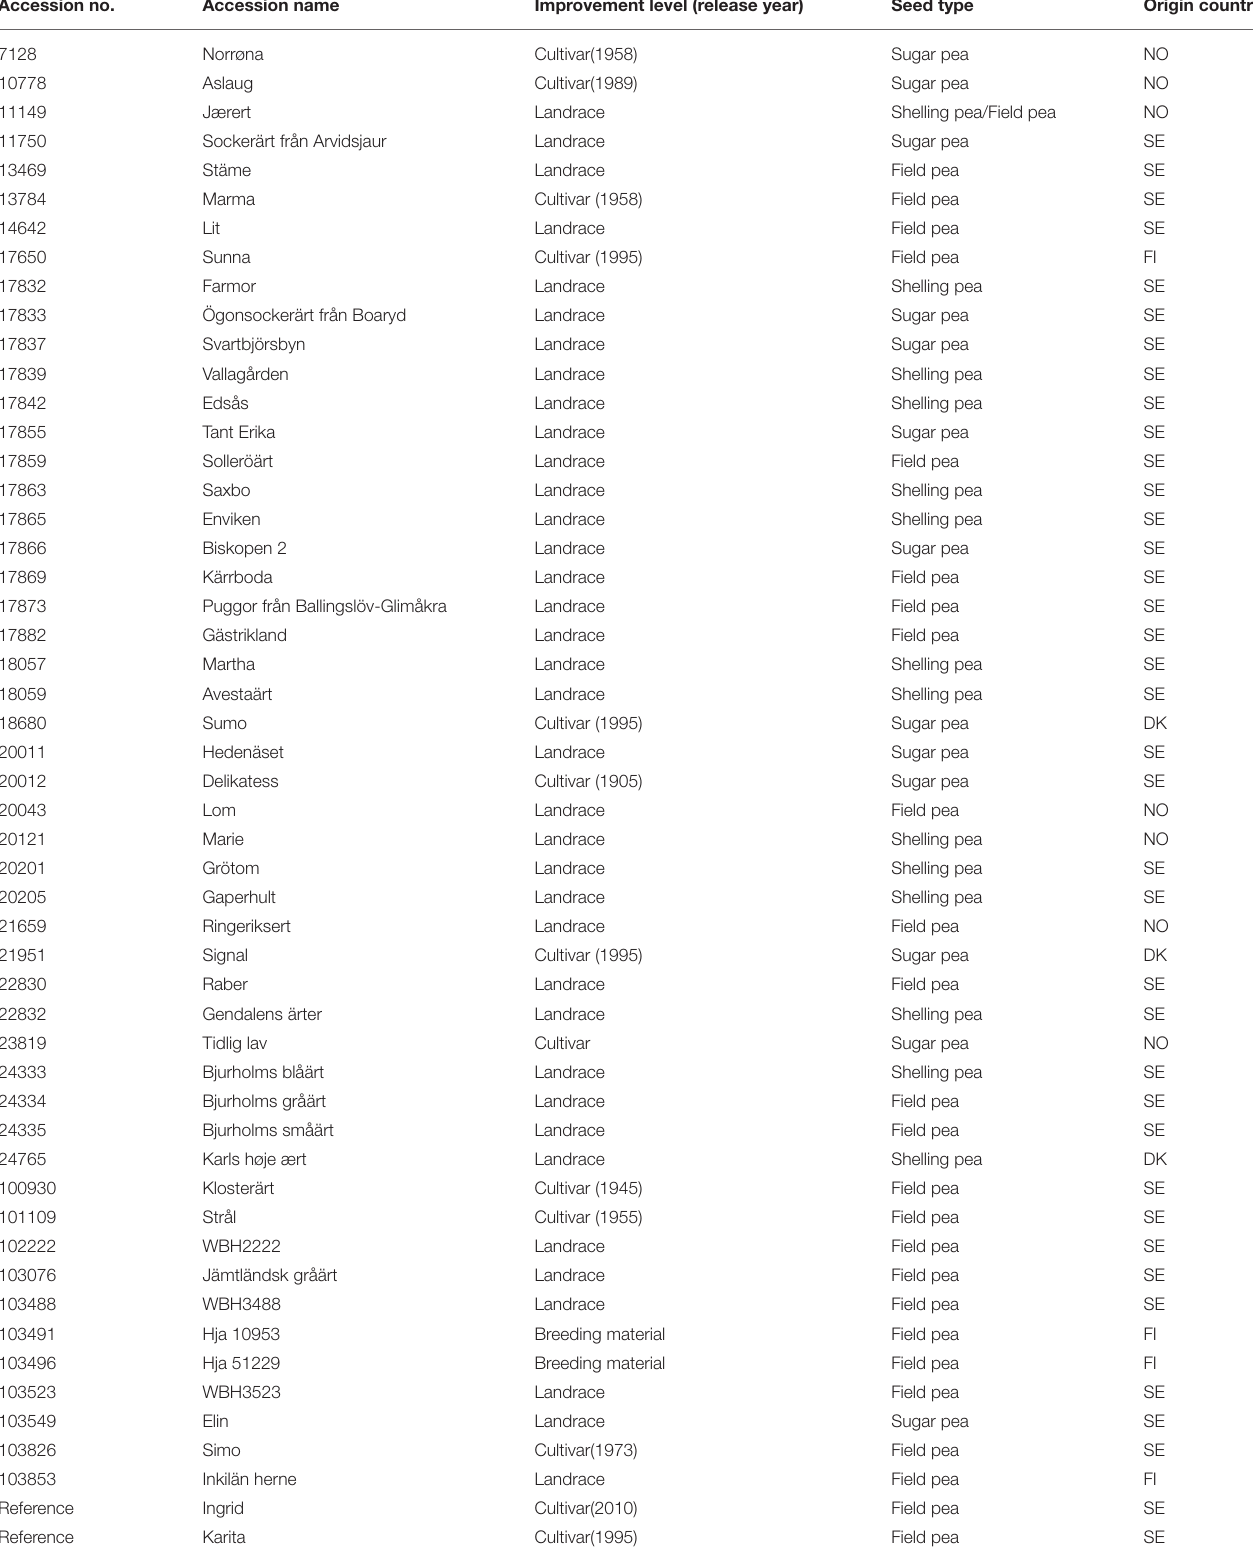
TABLE 1 | Information about accessions in field trials in 2018 and 2019. Accession